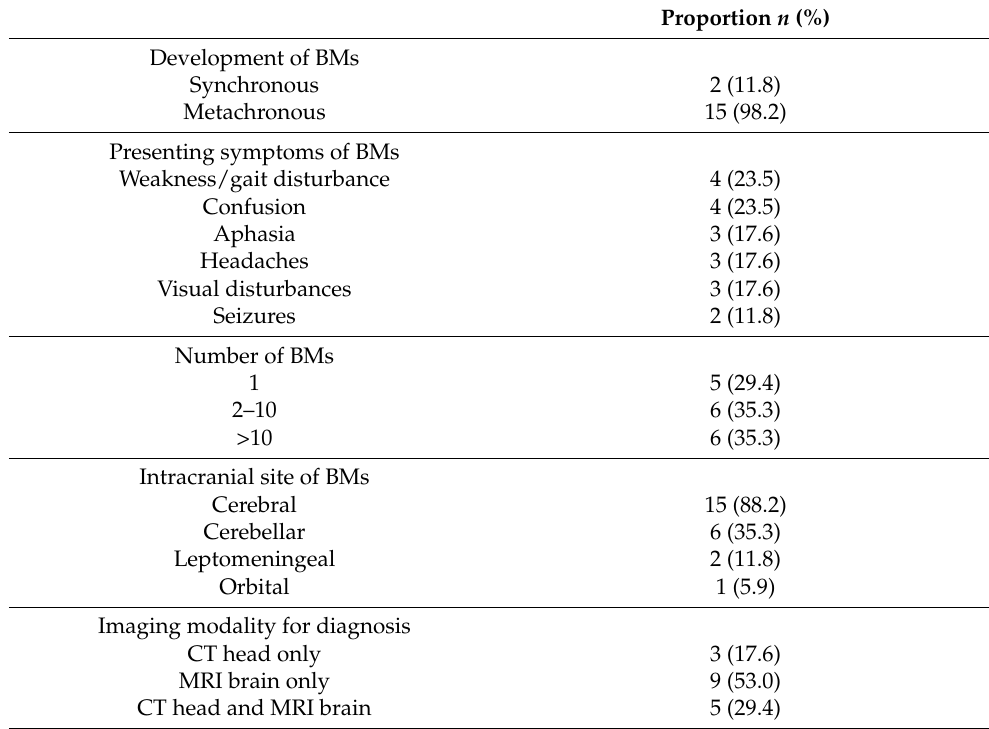
Table 4. Presentation, investigations and management summary of brain metastases in patients with extra-pulmonary neuroendocrine neoplasms ( n =